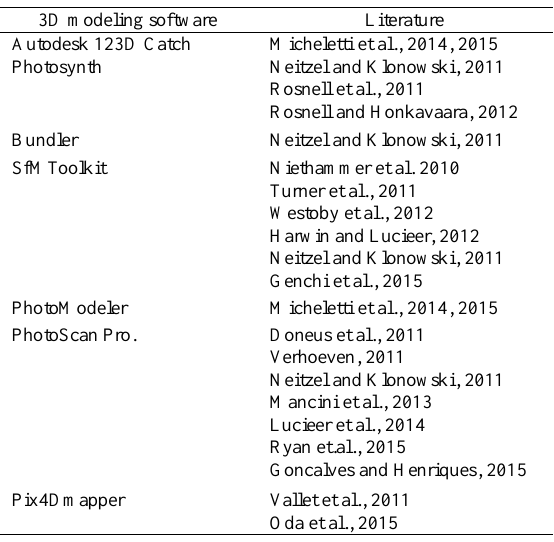
Table 2. 3D modeling software researched and corresponding studies PhotoScan and PhotoModeler are commercial software.